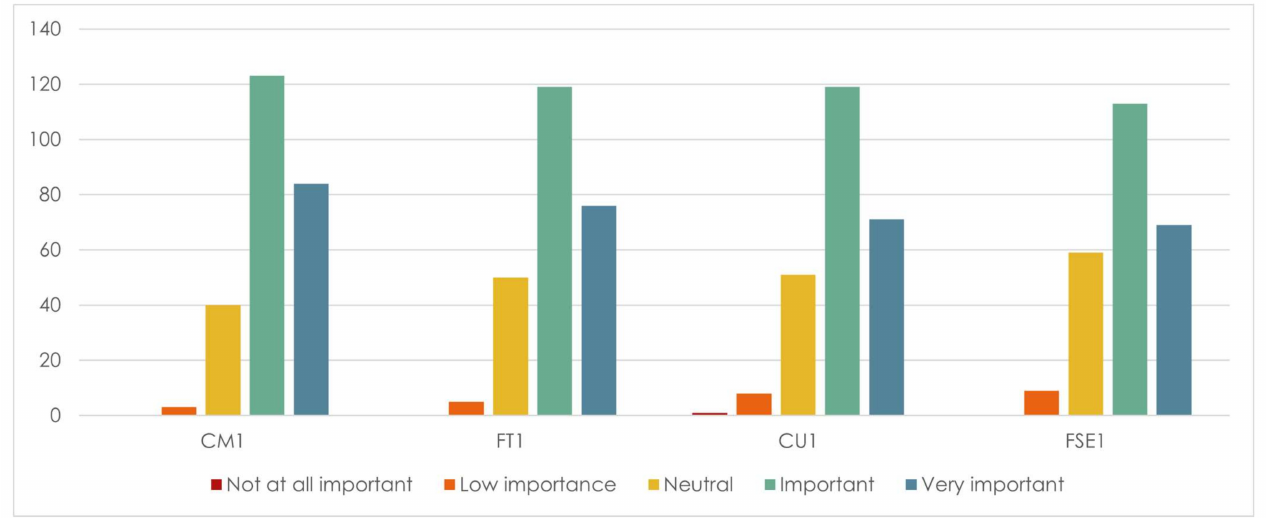
Figure 4. Perceived importance of lifestyle balance